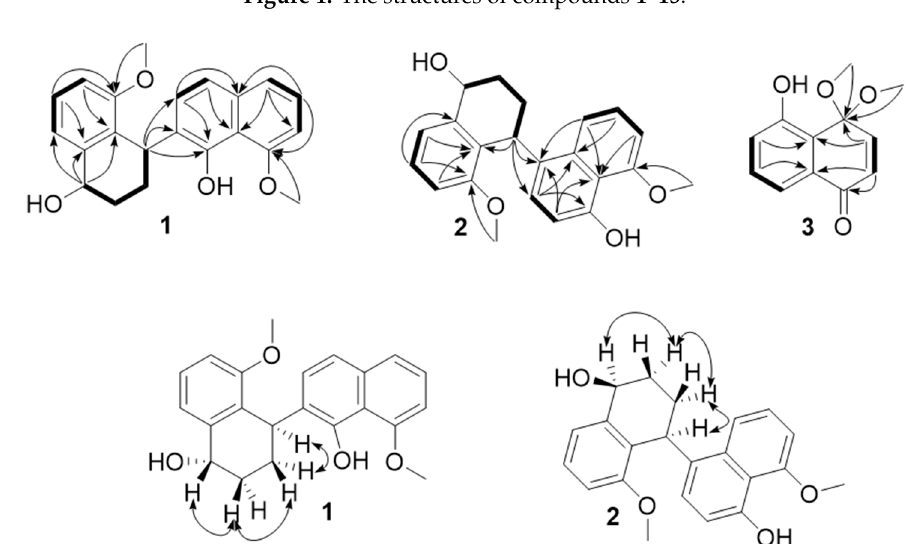
Molecules 2020 , 25 , x FOR PEER REVIEW 3 of 9 Figure 1. The structures of compounds 1 – 15 . Figure 1. The structures of compounds 1 – 15 .